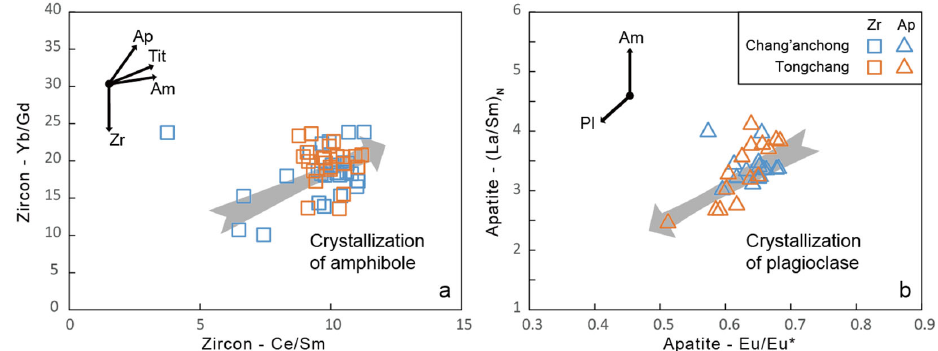
Figure 7. ( a ) Plots of zircon Ce/Sm vs. Yb/Gd; and ( b ) apatite Eu/Eu* vs. (La/Sm) N . The continuous- line arrows represent fractional crystallization vectors [83,87]. Ap, apatite; Tit, titanate; Am, amphi- bole; Pl, plagioclase; Zr, zircon.